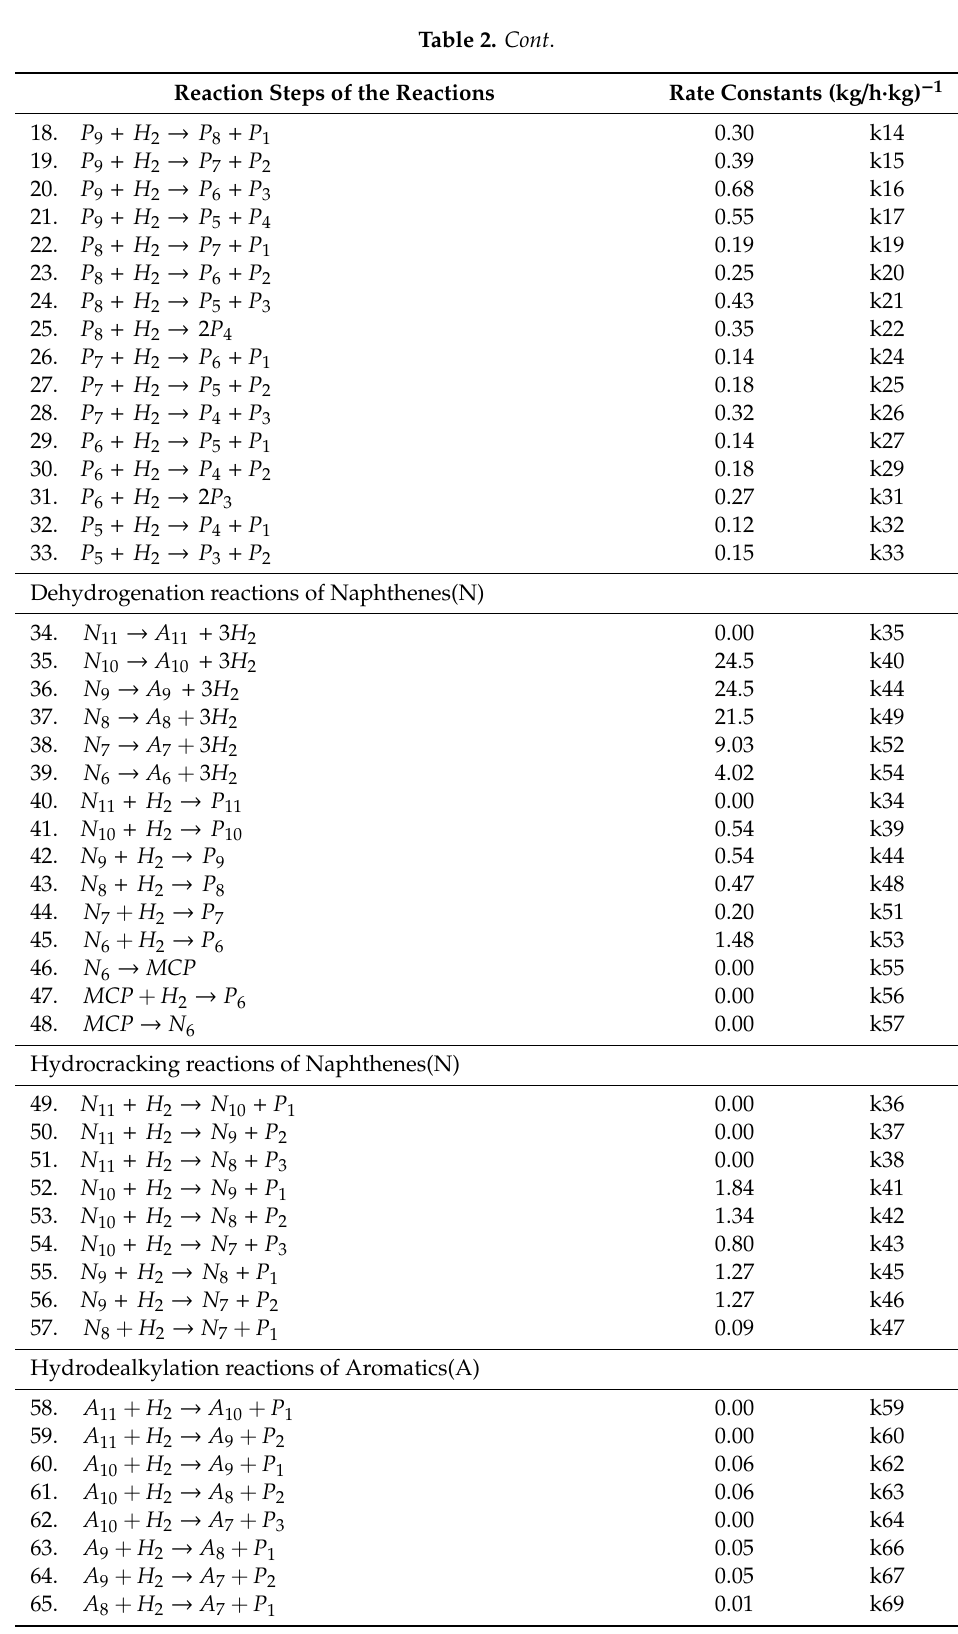
Reaction Steps of the